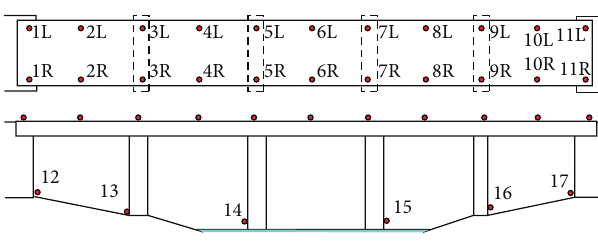
Figure 3: Measurements setup.